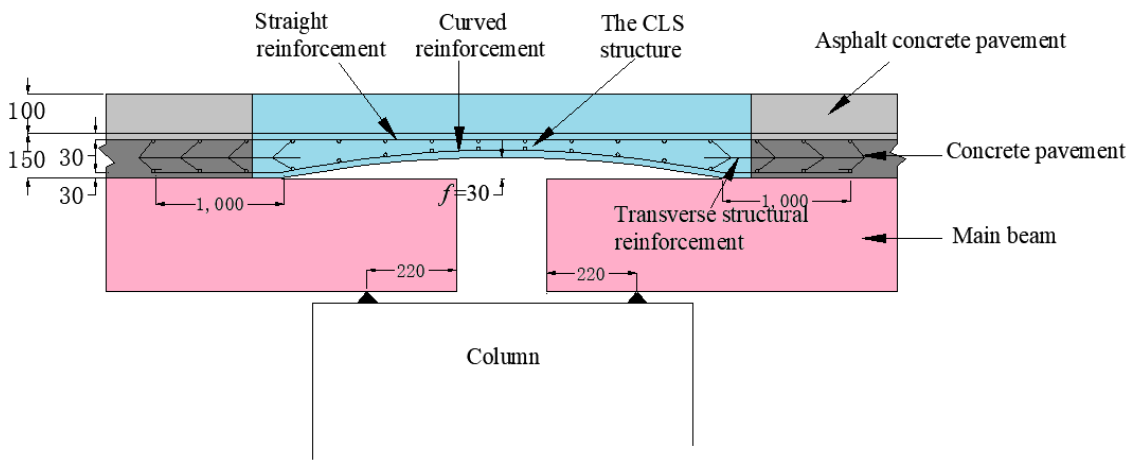
Figure 6. Schematic of the CLS (unit: mm).